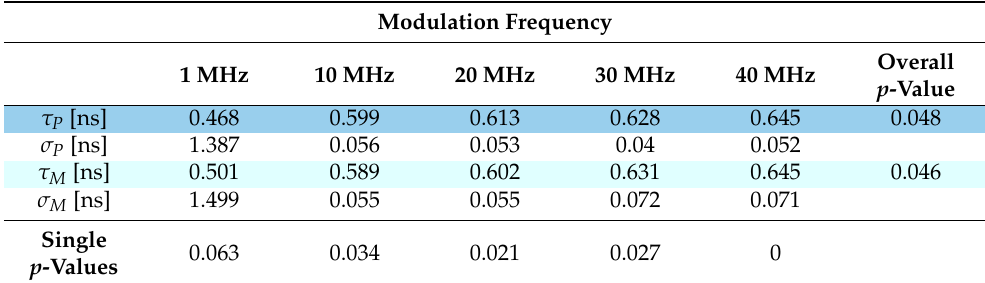
Table 1. Single and overall p -values for each frequency for the phase- and demodulation-lifetime of the FD technique, when measuring rose